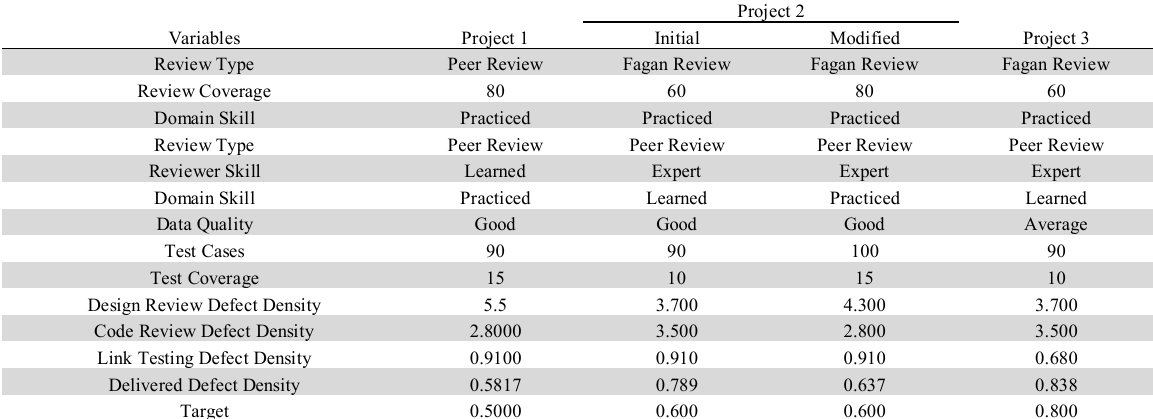
Implementation Data